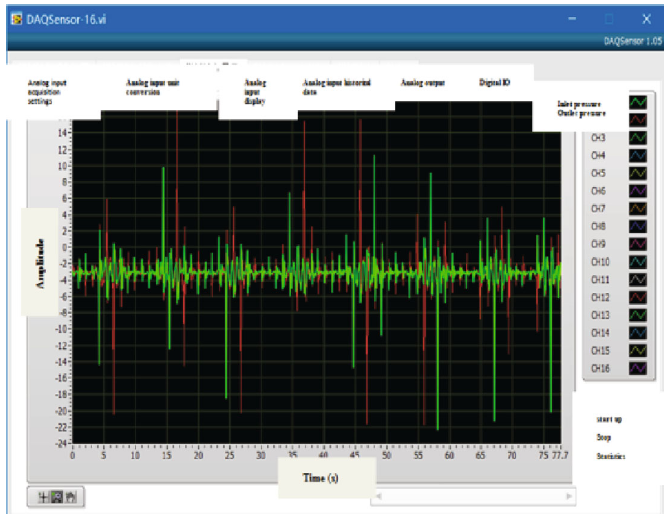
Figure 9: Real-time interface of acquisition status.